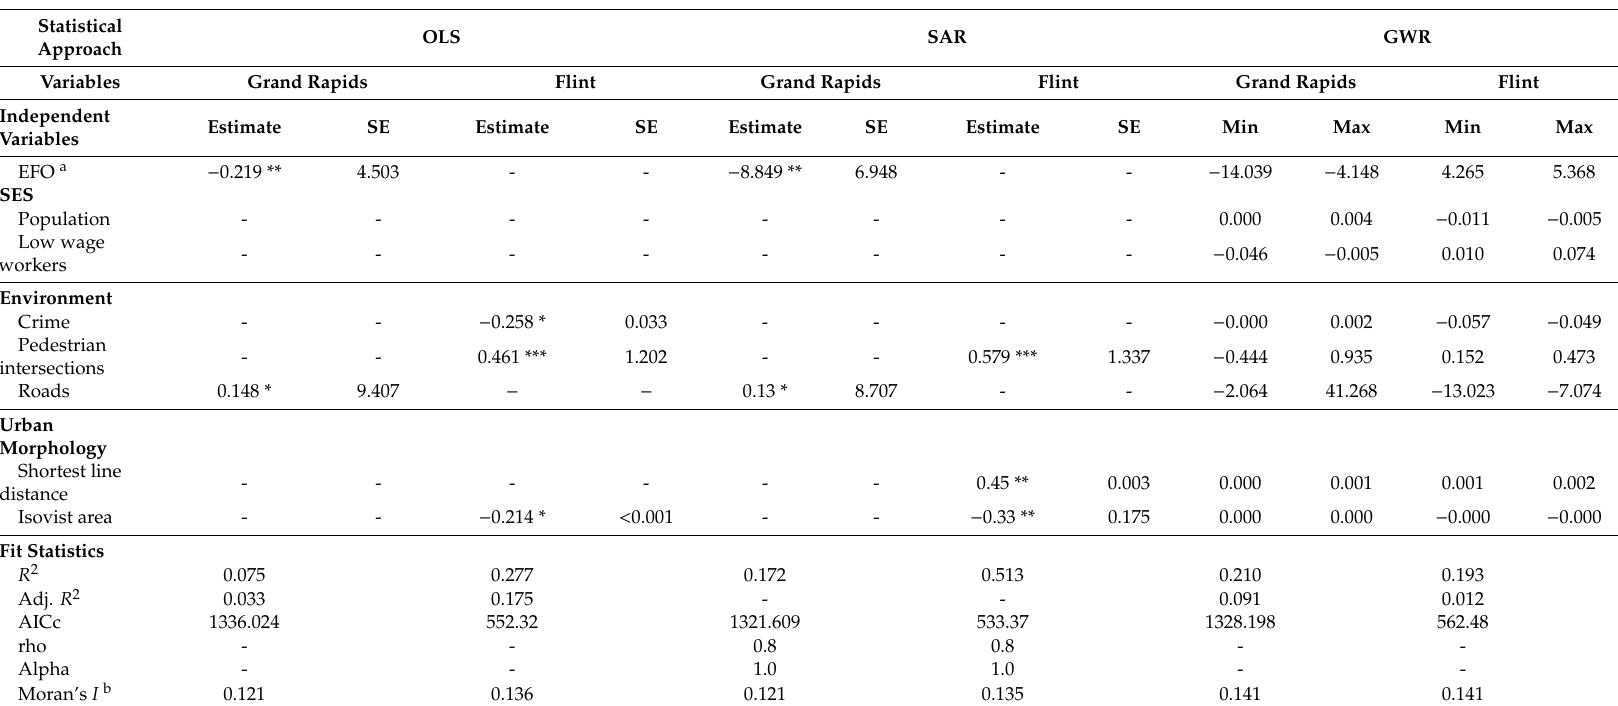
Table 5. Flint ( n = 60) and Grand Rapids ( n = 161) walking zone fully adjusted model coe ffi cients and diagnostic outputs. Statistical OLS SAR GWR Approach Variables Grand Rapids Flint Grand Rapids Flint Grand Rapids Independent Estimate Variables